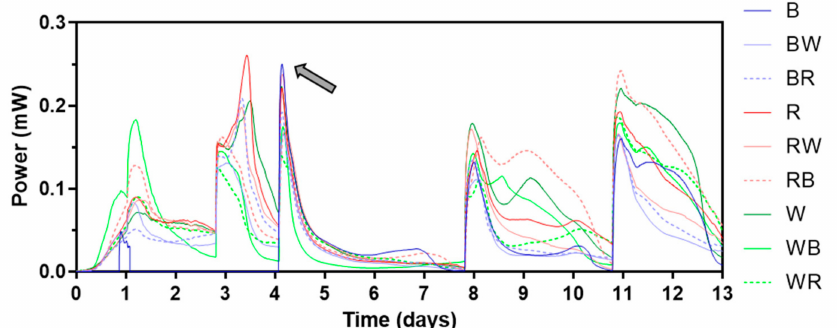
Figure 3. Power output profile of the first 13 days. The grey arrow indicates when continuous reading of power from brown ceramic separators began. Letters “B”, “R”, and “W” stand for “brown”, “red”, and “white” respectively. Data represent average values from triplicates of each ceramic type. See Figure S1 for the di ff erent types of ceramic separators.